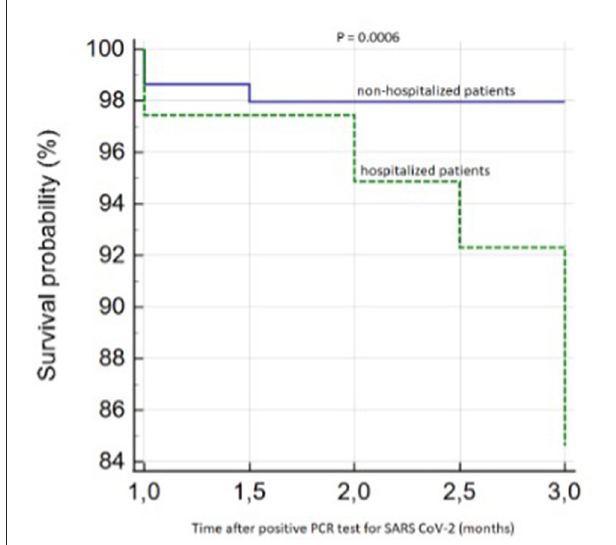
FIGURE 2 | Kaplan–Meier survival analysis (hospitalized vs. non-hospitalized